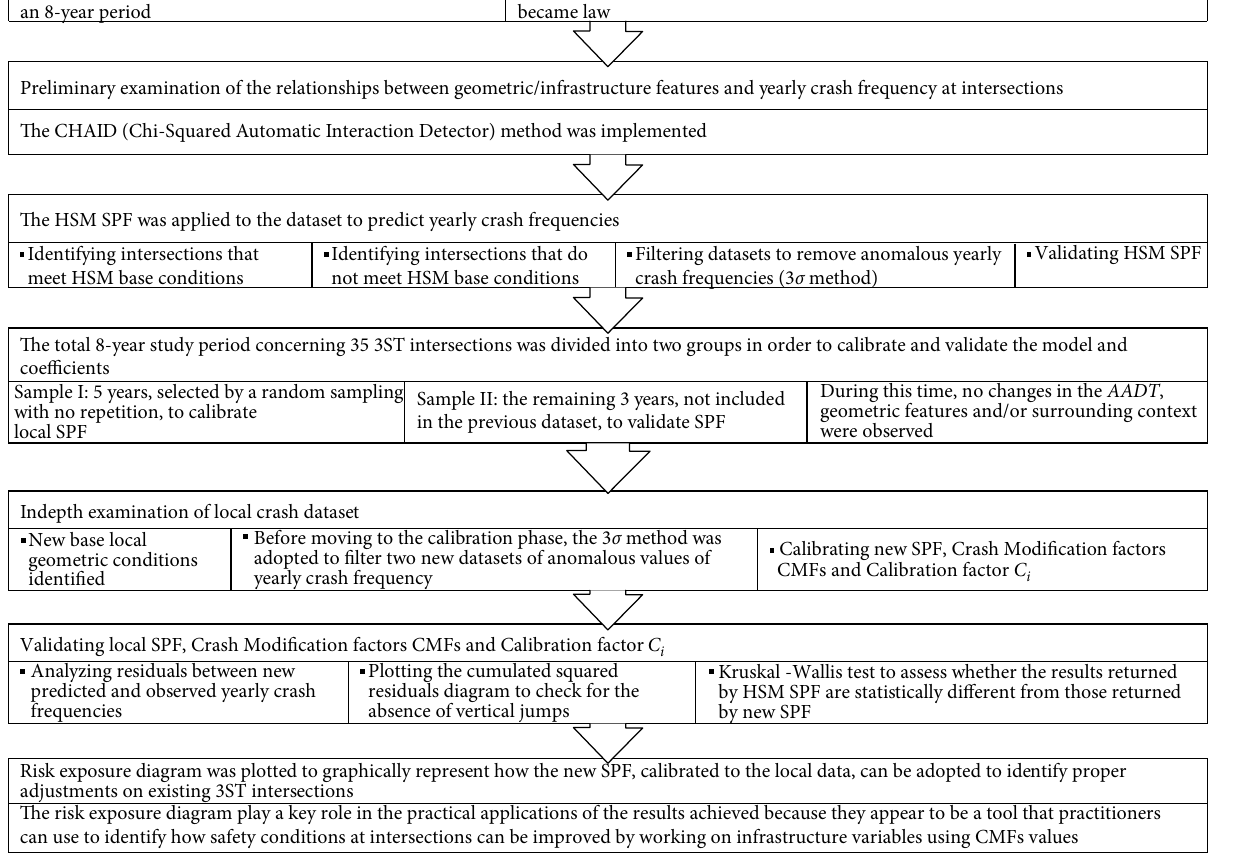
Figure 1: The methodological process to calibrate the functions and validate the